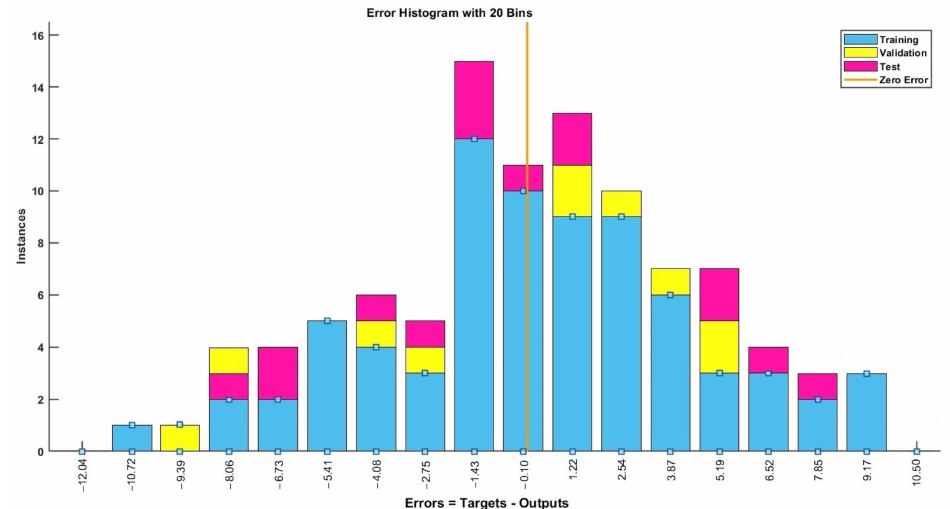
Figure 15. Error histogram with 20 bins for the training, validation and testing of BPNN for sulfur recovery prediction.